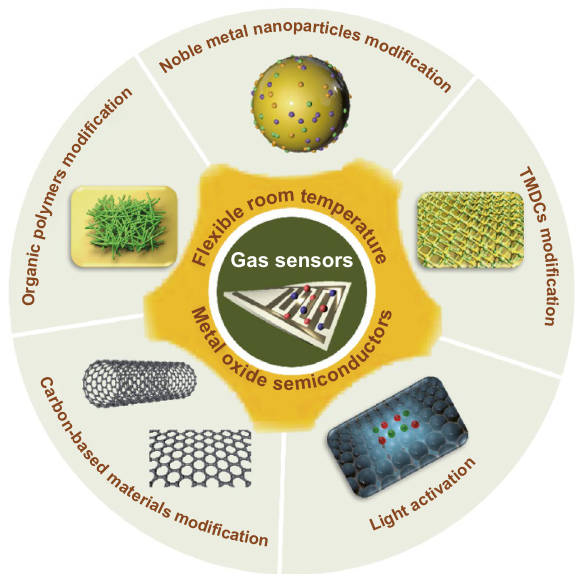
Fig. 1 The strategies to achieve high‑performance FRT MOS‑based chemiresistive gas